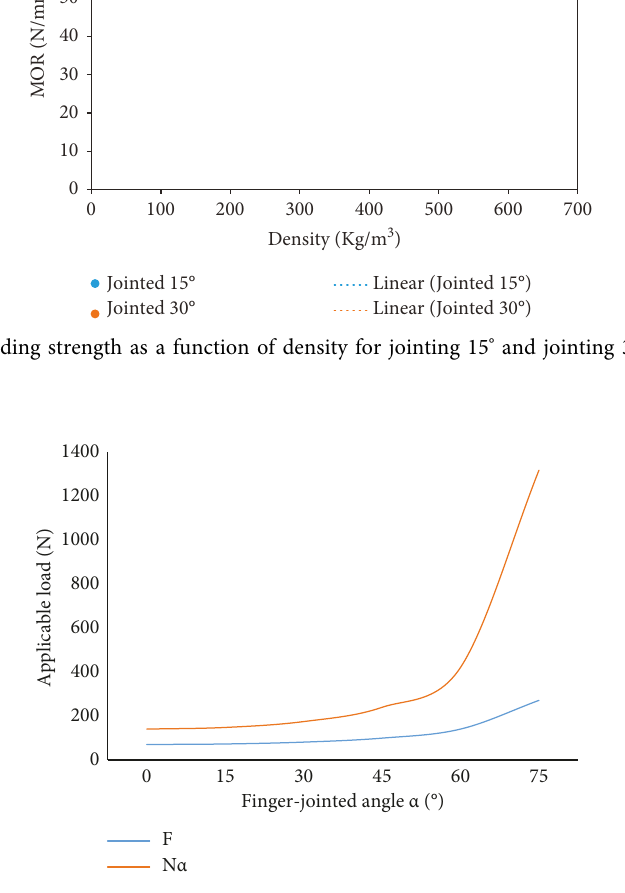
Figure 14: Evolution curve of the loads to be applied as a function of the angle α